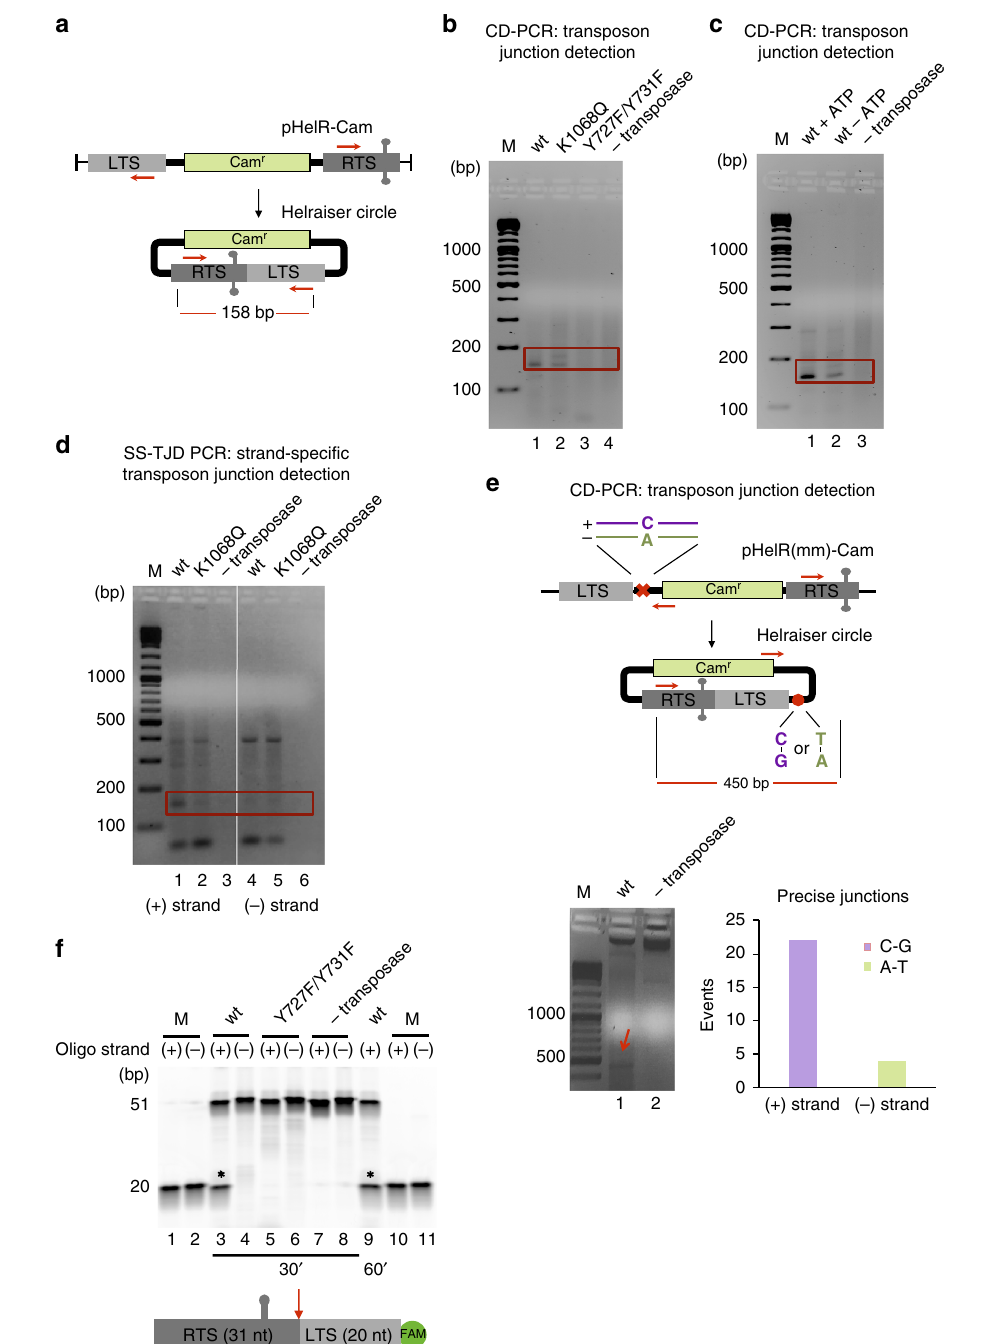
Fig. 5 In vitro transposon-end junction formation and cleavage with puri fi ed Helraiser transposase. a Helraiser donor plasmid (pHelR-Cam), used in linear form, and resulting Helraiser circle. Red arrows represent fwd and rev nested primer binding sites; red line: expected size of the PCR product. b PCR detection of Helraiser transposon-end junctions. M marker, Red box marks the position of the expected PCR product. c PCR detection of Helraiser transposon-end junctions ±ATP. d Strand-speci fi c PCR detection of transposon-end junctions generated in vitro by the Helraiser transposase. Lanes 1 – 3: detection of plus strand. Lanes 4 – 6: detection of minus strand. e Top: schematic of Helraiser heteroduplex donor plasmid, pHelR(mm)-Cam and resulting Helraiser circle. Red x mismatch position within transposon sequence; red circle position of the mismatch on the donor molecule used in the analysis of the Helraiser circles. Bottom left: PCR detection of the transposon-end junctions generated from the heteroduplex donor. Red arrow indicates PCR product of the expected size spanning the mismatch position. Bottom right: DNA base composition at the mismatch position in the obtained PCR product. Most of the detected junctions arose from the plus strand; four arose from the minus strand. f Top: cleavage of ss 51-mer DNA oligonucleotides representing plus and minus strand of transposon-end junction. Marker (M): 20 bp oligonucleotide corresponding to the expected cleavage product for each strand. Bottom: schematic representation of the ss oligonucleotide used in cleavage reactions. Red arrow indicates the cleavage site. Oligonucleotide sequences are listed in Supplementary table